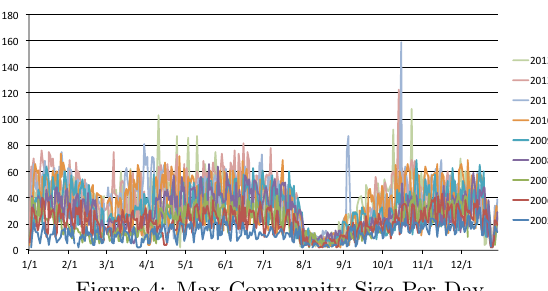
Figure 4: Max Community Size Per